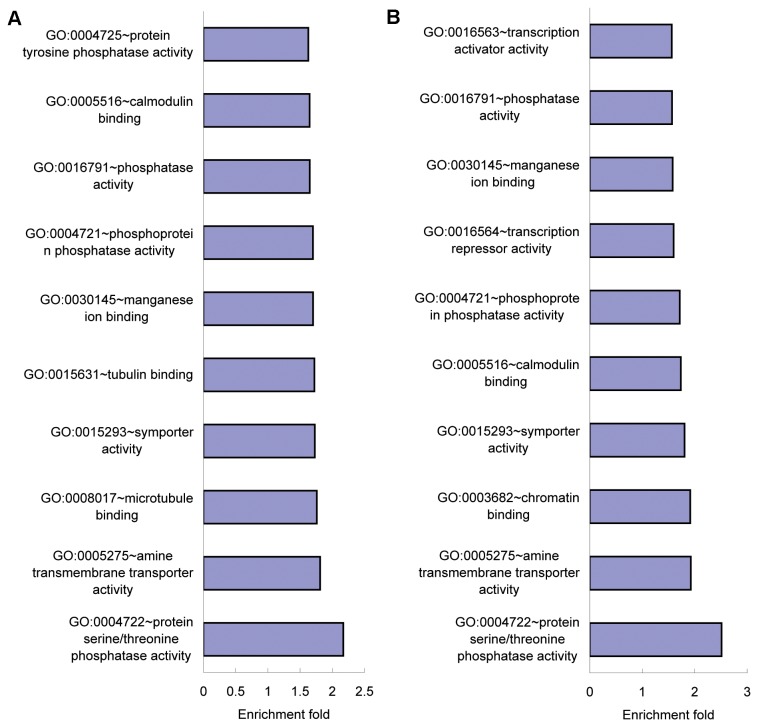
Top 10 significantly enriched GO terms of molecular function for the predicted targets.(A) Top ten significantly enriched GO terms of molecular function for the predicted targets of differentially expressed microRNAs in response to influenza virus BJ501 infection. (B) Top 10 significantly enriched GO terms of molecular function for the predicted targets of differentially expressed microRNAs in response to influenza virus PR8 infection.